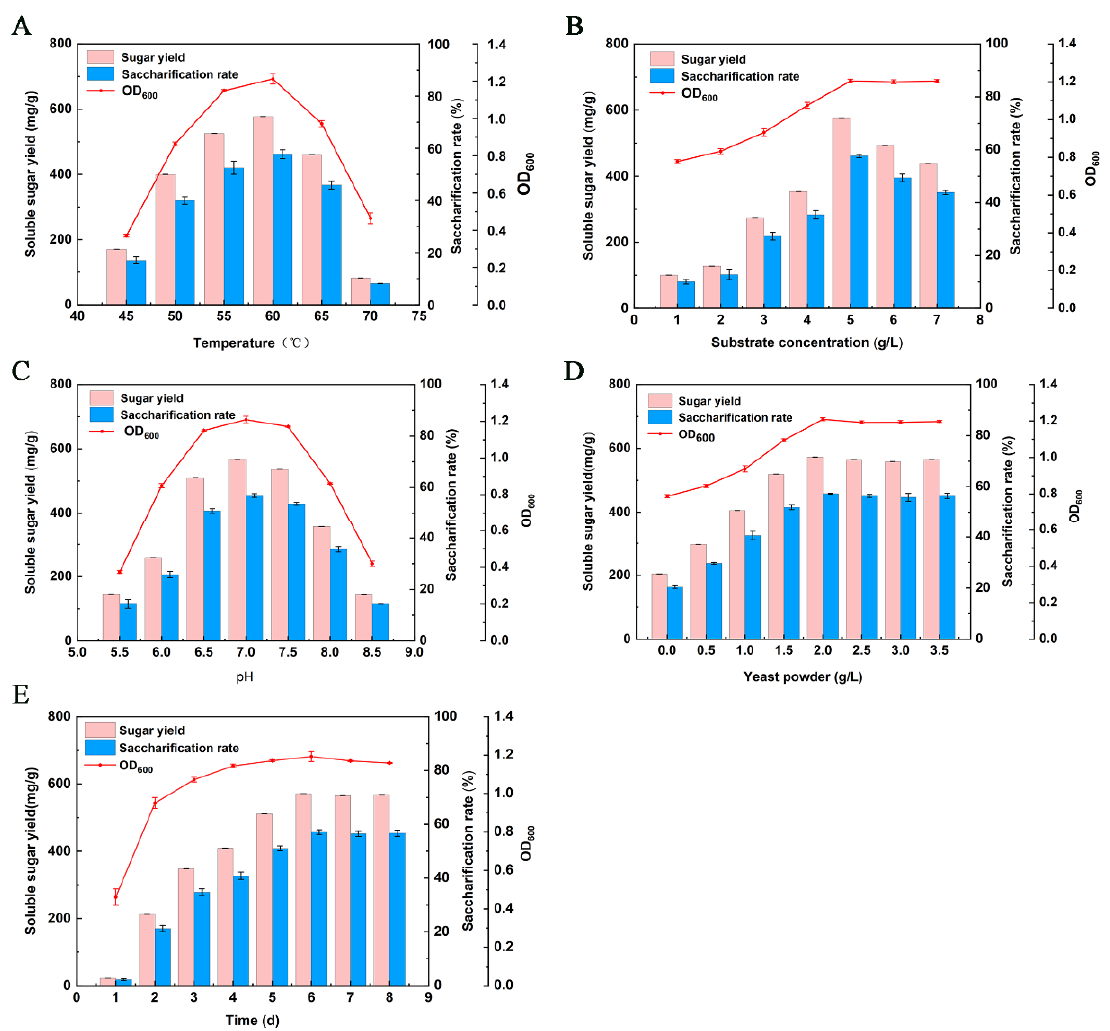
Figure 4. Sugar production effect of saccharifying strains under different culture conditions: ( A ). Effect of tmperature; ( B ). Effect of substrate concentration; ( C ). Effect of pH; ( D ). Effect of yeast powder; ( E ). Effect of time.